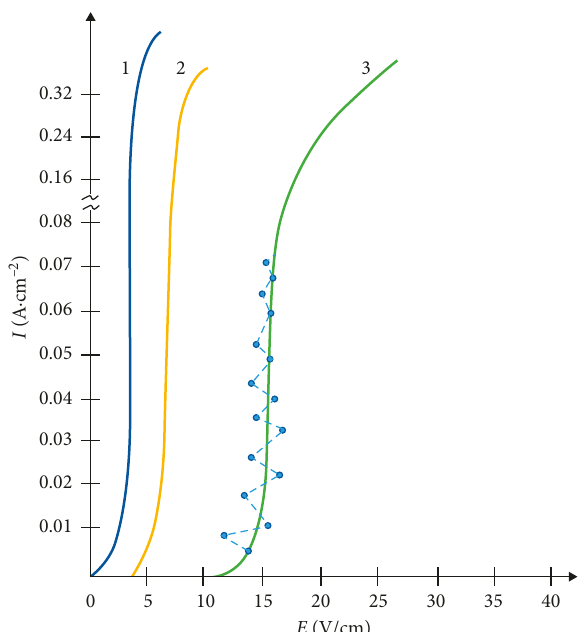
Figure 1: CVC of n-GaAs samples measured at different magnetic fields in the strictly constant current regime at R curves 1 to 3) and in the pseudocurrent regime when R (dotted curves in